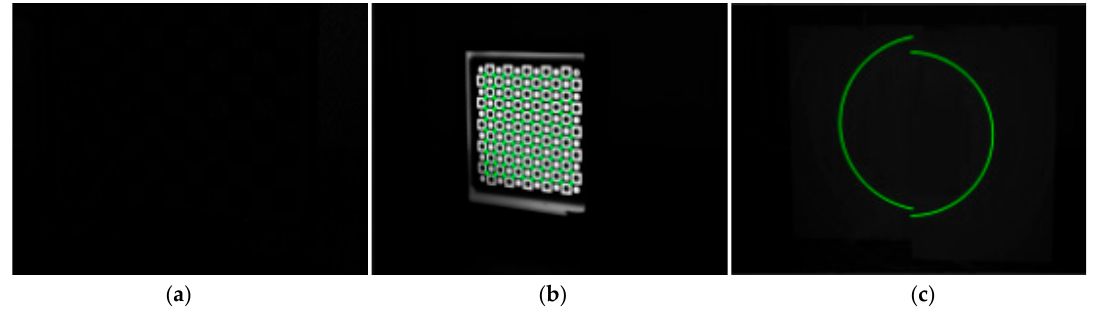
Figure 9. Calibration images based on two methods in the dim light environment. ( a ) Calibration images of the normal checkerboard target; ( b ) Calibration images of the light-emitting checkerboard target; ( c ) Calibration images of the double parallel planar target.